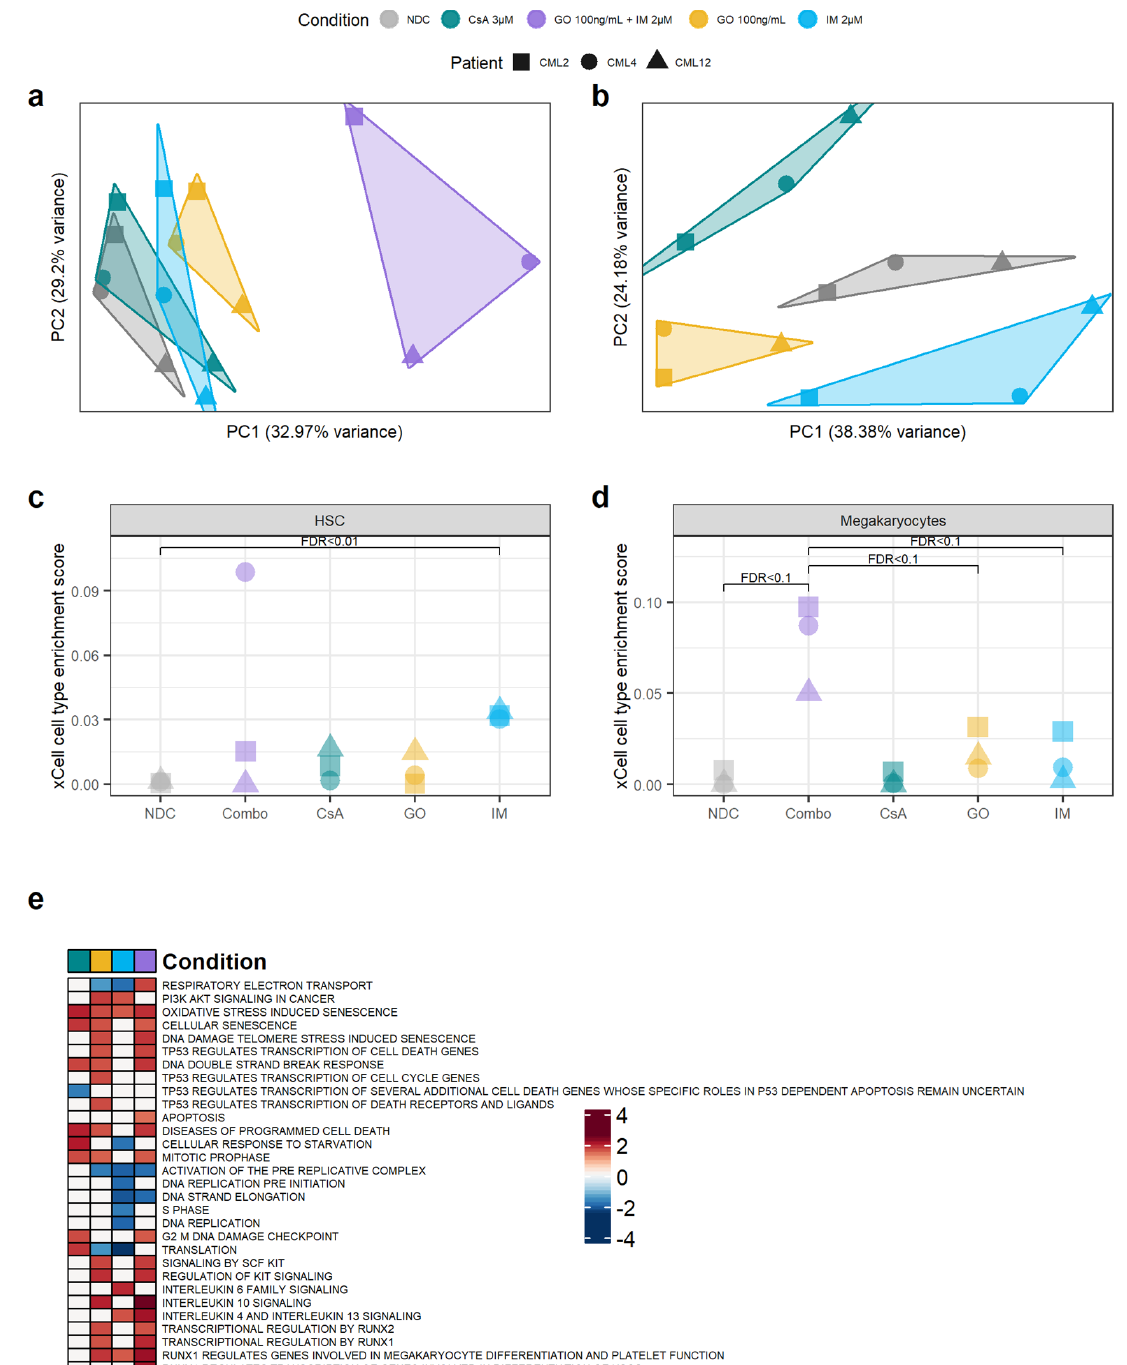
Figure 5. Targeting the TKIi signature alters the transcriptome of CML CD34 + cells. ( a ) PCA plot of all the samples sequenced. The transcriptomic changes caused by the GO + IM combination explain most of the variability of the dataset. ( b ) PCA plot after removing the GO + IM combination samples. This allows for a better understanding of the differences between the single treatments, which seem to be independent of each other (each treatment is projected in a different direction from the NDC). ( c ) Comparison of the HSC enrichment score generated by xCell for each sample. IM-treated samples were significantly enriched by HSC compared to the NDC (FDR < 0.01). ( d ) Comparison of the megakaryocyte enrichment score generated by xCell for each sample. The GO + IM was borderline significantly enriched on megakaryocytes compared either to the NDC or to GO/IM single treatment (FDR < 0.1). ( e ) Shortlist of the Reactome pathways significantly enriched in any of the conditions by GSEA. White squares represent non-significant pathways (independently of the enrichment score). Blue squares represent downregulated pathways, while red squares represent upregulated pathways. Full list of pathways can be found in Figure S8. (all) Each shape represents an individual patient, while each colour represents an individual treatment.